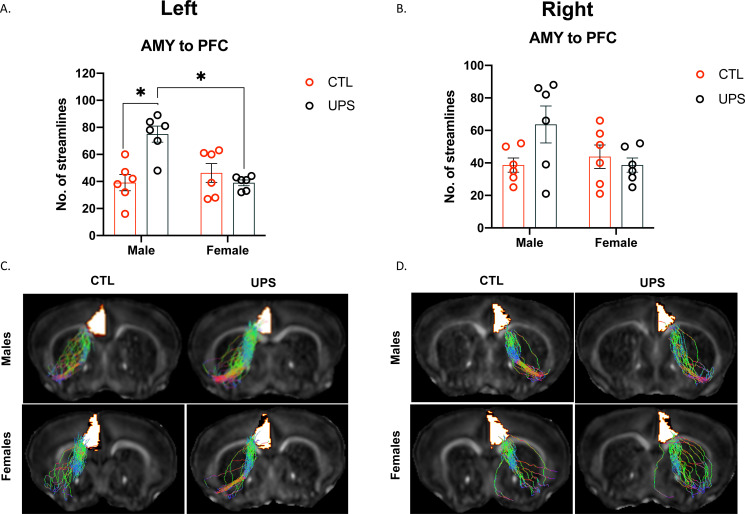
Amygdala–prefrontal cortex tractography for the left (A and C) and the right (B and D) hemispheres.Quantification of the number of streamline projections is shown in A and B and representative tracing presented in C and D. n = 6 per rearing condition and sex. Graphs represent mean and SEM, *p<0.05.